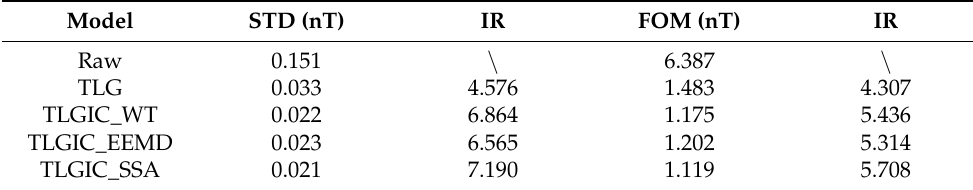
Figure 5. The extraction results of three methods for ECMI of the second–lap. ( a ) the compensated STMF of the fluxgate vector magnetometer; ( b ) the characteristic signal of ECMI extracted by SSA; ( c ) the characteristic signal of ECMI extracted by WT; ( d ) the characteristic signal of ECMI extracted by EEMD. Table 1. Compensation results for the first–lap flight data.